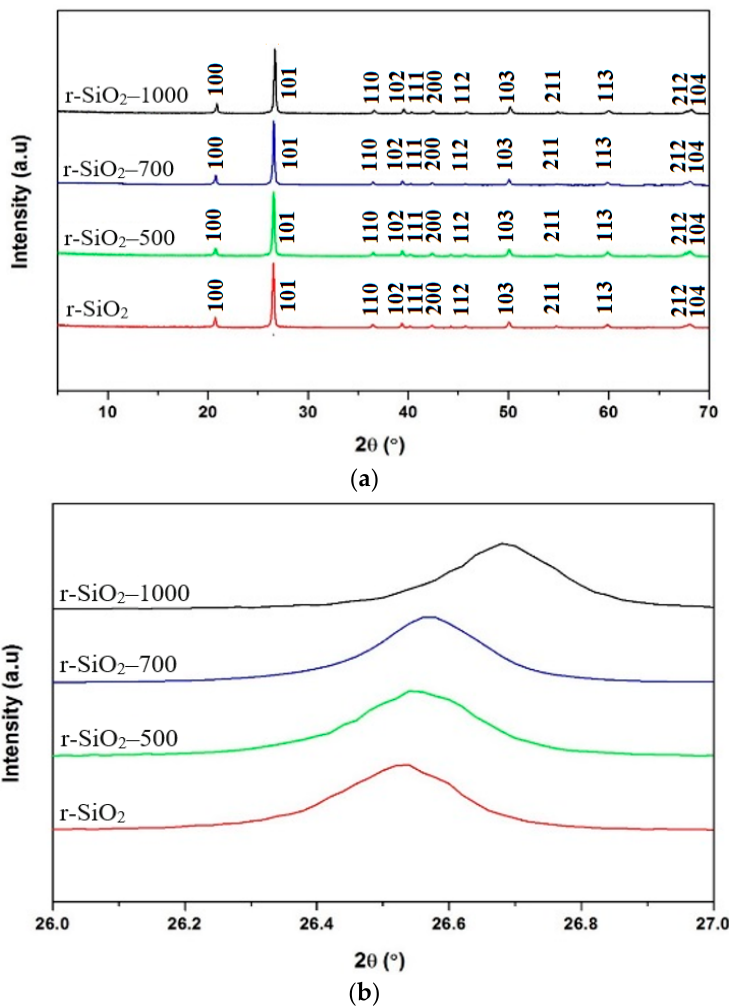
Figure 2. XRD pa tt erns of ( a ) unheated and heated fl int at 500 °C, 700 °C, and 1000 °C, ( b ) evolution Figure 2. XRD patterns of ( a ) unheated and heated flint at 500 ◦ C, 700 ◦ C, and 1000 ◦ C, ( b ) evolution of the main peak (101). of the main peak